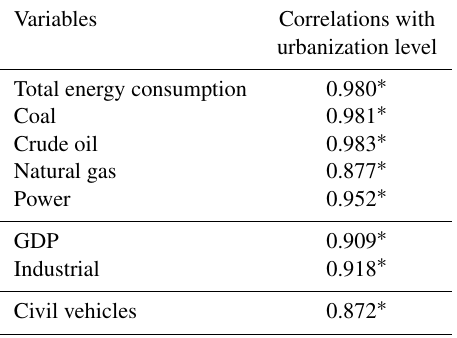
Table 1. Pearson correlations between variations in urbanization level (ULE) and energy consumption, gross domestic product (GDP), and civil vehicles for 1960–2013 in China based on the China Statistical